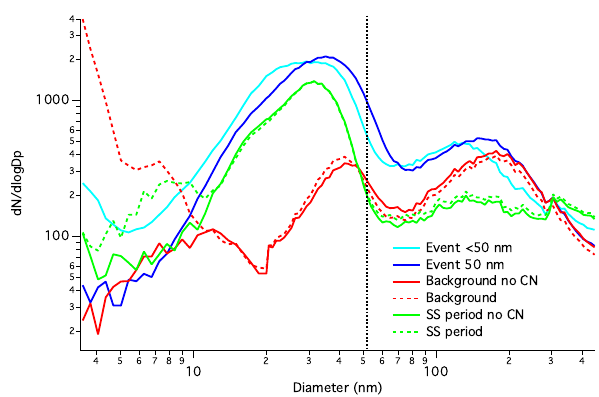
Fig. 2. Mean particle size distributions for the four defined particle type periods. Coastal nucleation (CN) was observed during the background and seasalt periods used for HTDMA averages, and the plots show those periods both with and without the CN events. The dashed vertical line indicates the dry size for which HTDMA observations were made.